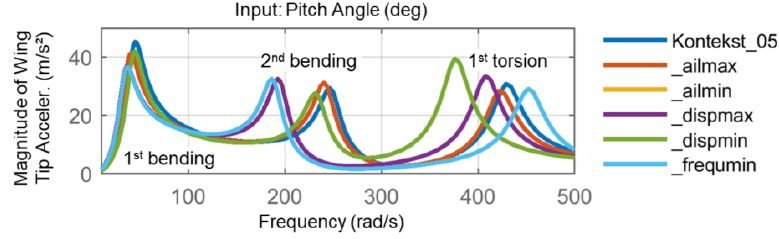
Figure 17. Transfer functions from pitch angle to wing tip acceleration.